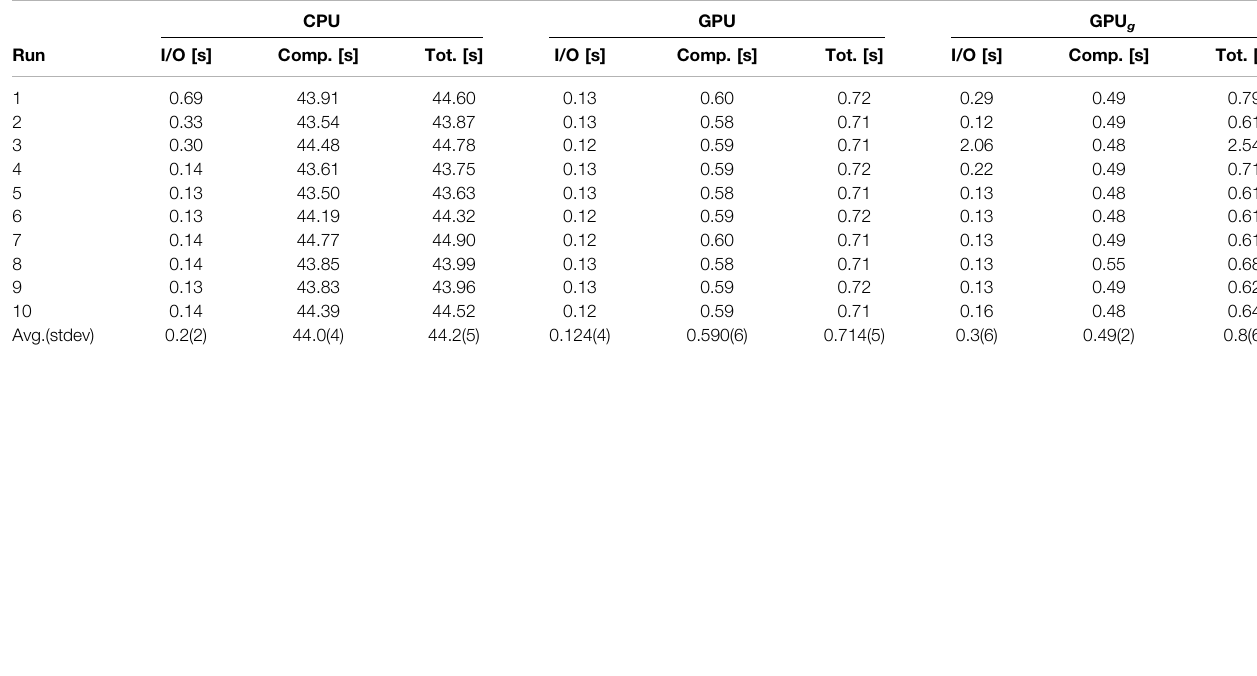
TABLE A2 | Breakdown of the Event Loop time (Tot.) into I/O time (I/O) and compute time (Comp.) for the simulation of Electrons with E ≈ 4 TeV and η min (cid:2) 0 . 2, corresponding to the 3rd row in Table 3 . CPU GPU GPU